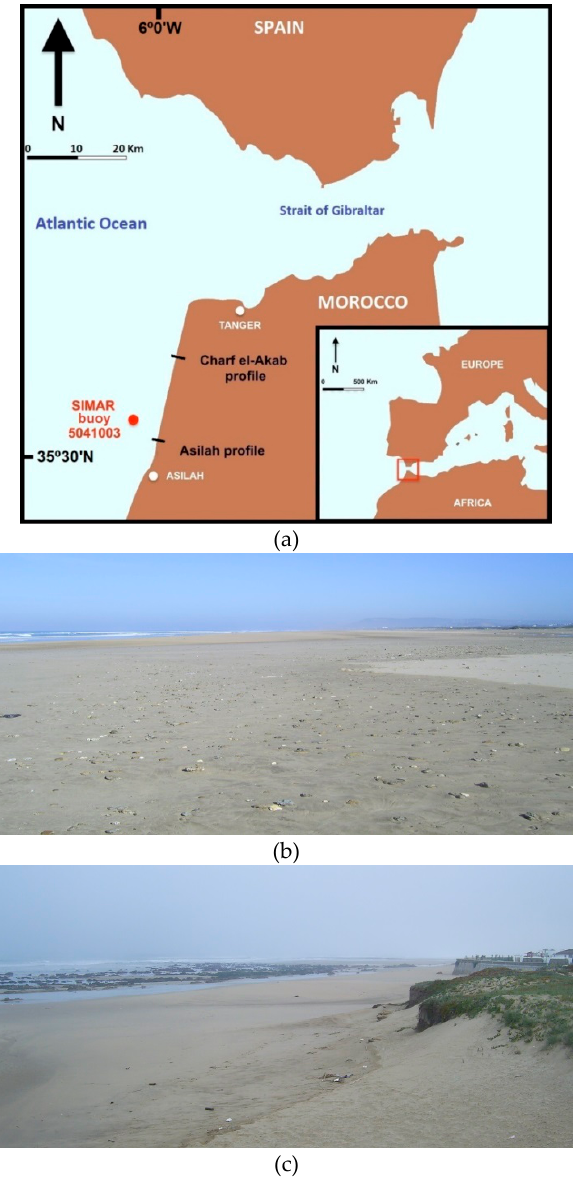
Figure 1. ( a ) Location of Charf el-Akab and Asilah beaches on the north-west coast of Morocco facing the Atlantic Ocean. Wave and climate data were collected from a virtual SIMAR buoy in front of Asilah (www.puertos.es); ( b ) view of Charf el-Akab sandy beach; ( c ) view of the Asilah beach supported by a reef flat. Photographs taken by the authors.